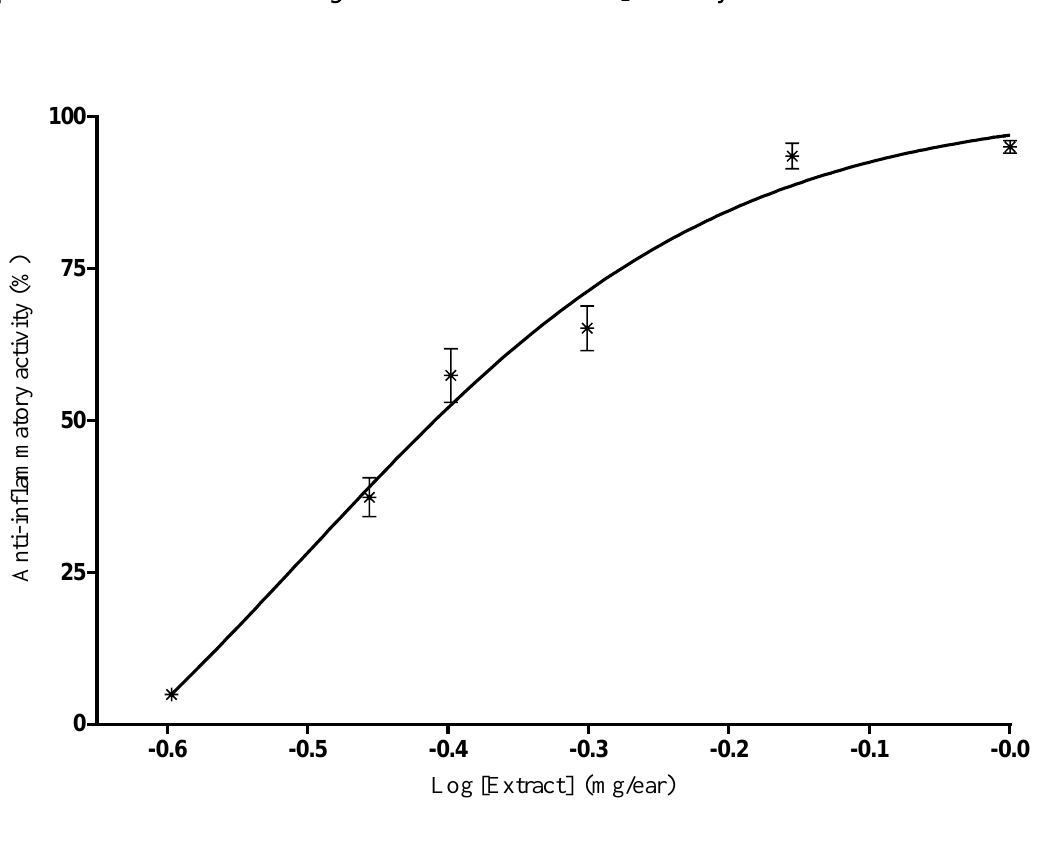
value of 0.31mg/ear was 50